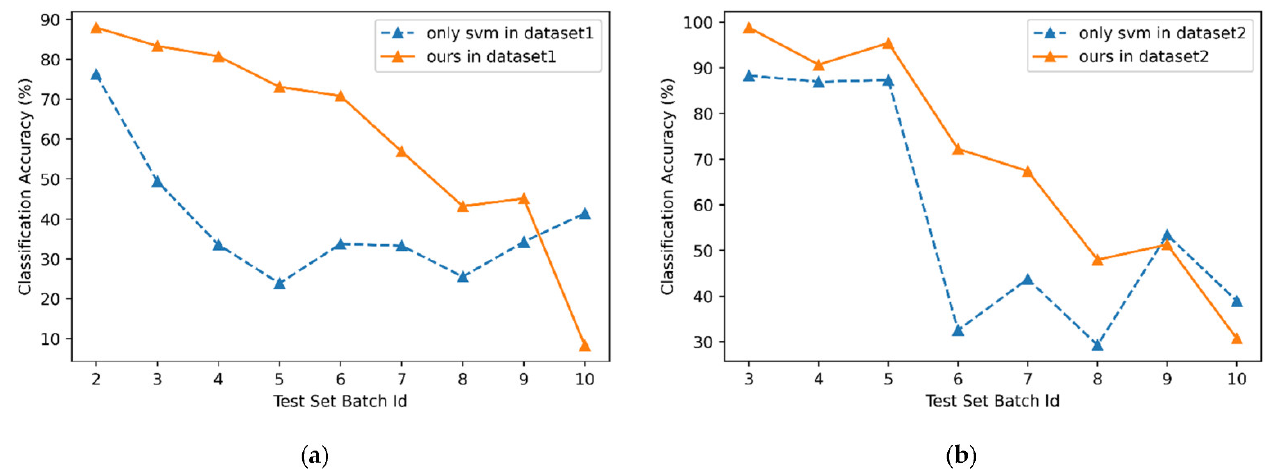
Figure 3. The experimental comparison between only svm and ours ( a ) in dataset1 and ( b ) in dataset2.